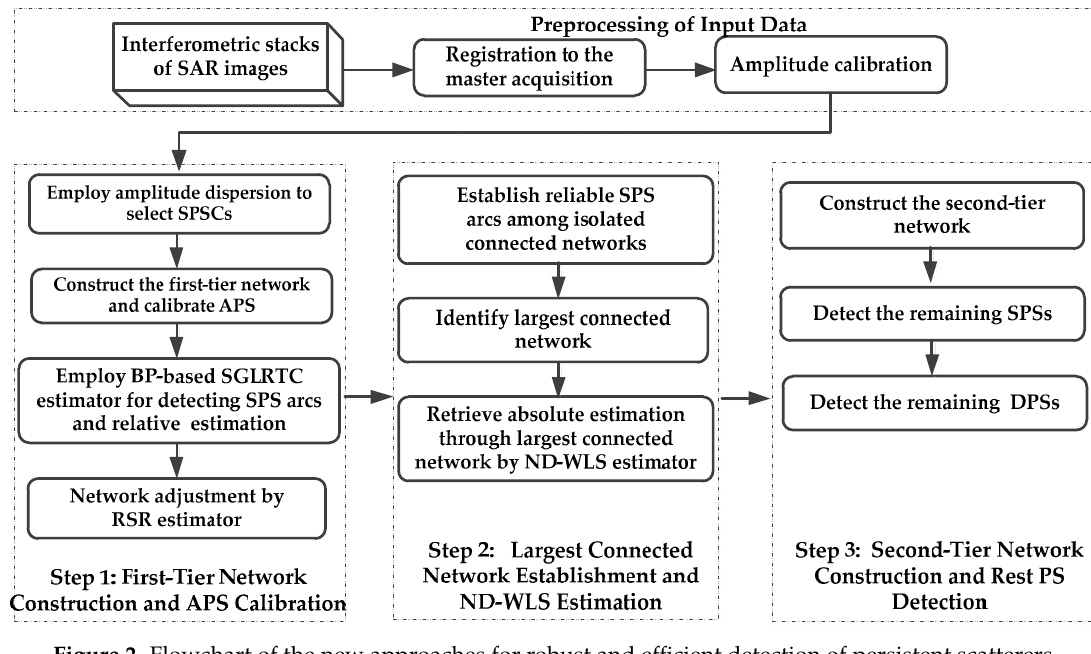
Figure 2. Flowchart of the new approaches for robust and efficient detection of persistent scatterers (PSs). Abbreviations: SPS, single persistent scatterer; DPS, double persistent scatterer; SPSC, SPS candidate; APS, atmospheric phase screen; BP, Beam-Forming; SGLRTC, sequential generalized likelihood ratio test with cancellation; RSR: residue-to-signal ratio; ND-WLS, network decomposition weighted least square.